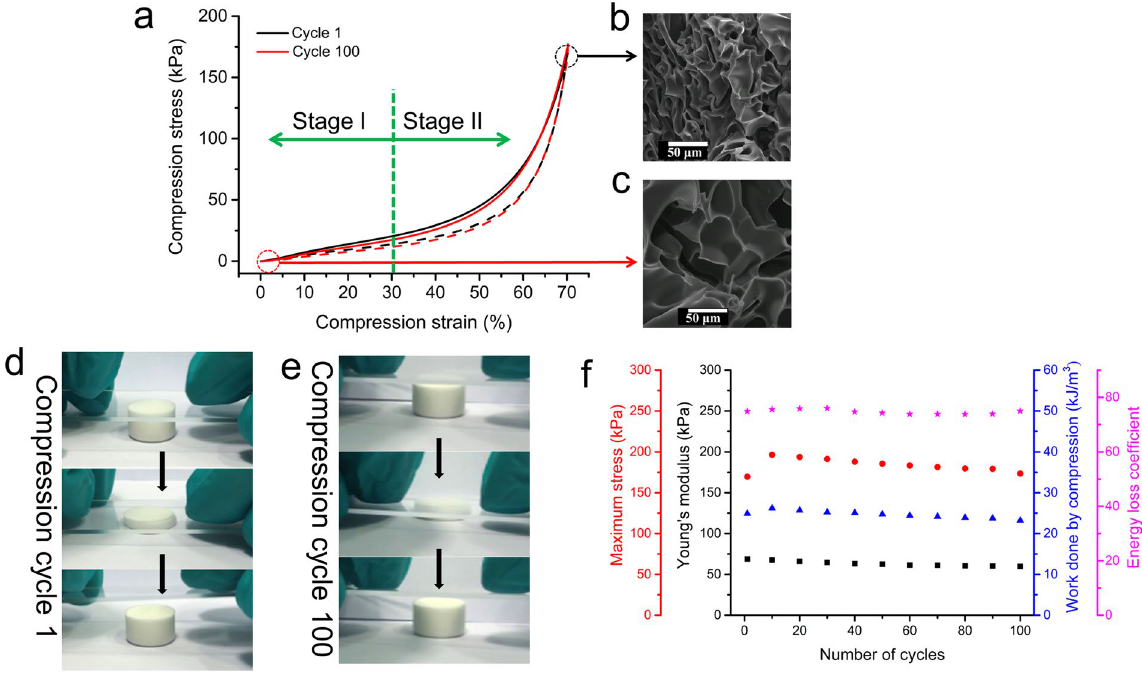
Figure 5. Cyclic compressive properties of CG-G4-5% at ambient temperature. ( a ) Compressive stress-strain curves of cycle 1 and cycle 100 of loading (solid lines) and unloading (dashed lines). ( b ) SEM image of the dendrimer cryogel under 70% strained compression in cycle 1. ( c ) SEM image of the dendrimer cryogel after recovery from 100 cycles of compression. ( d ) A set of real-time images to demonstrate the recovery of the dendrimer cryogel from one cycle of manual compression. ( e ) A set of real-time images to demonstrate the recovery of the dendrimer cryogel from 100 cycles of manual compression. ( f ) Young’s modulus ( ■ ), maximum stress ( ), work done by compression ( ), and energy loss coefficient ( ) of the dendrimer cryogel experiencing different numbers of cycles of